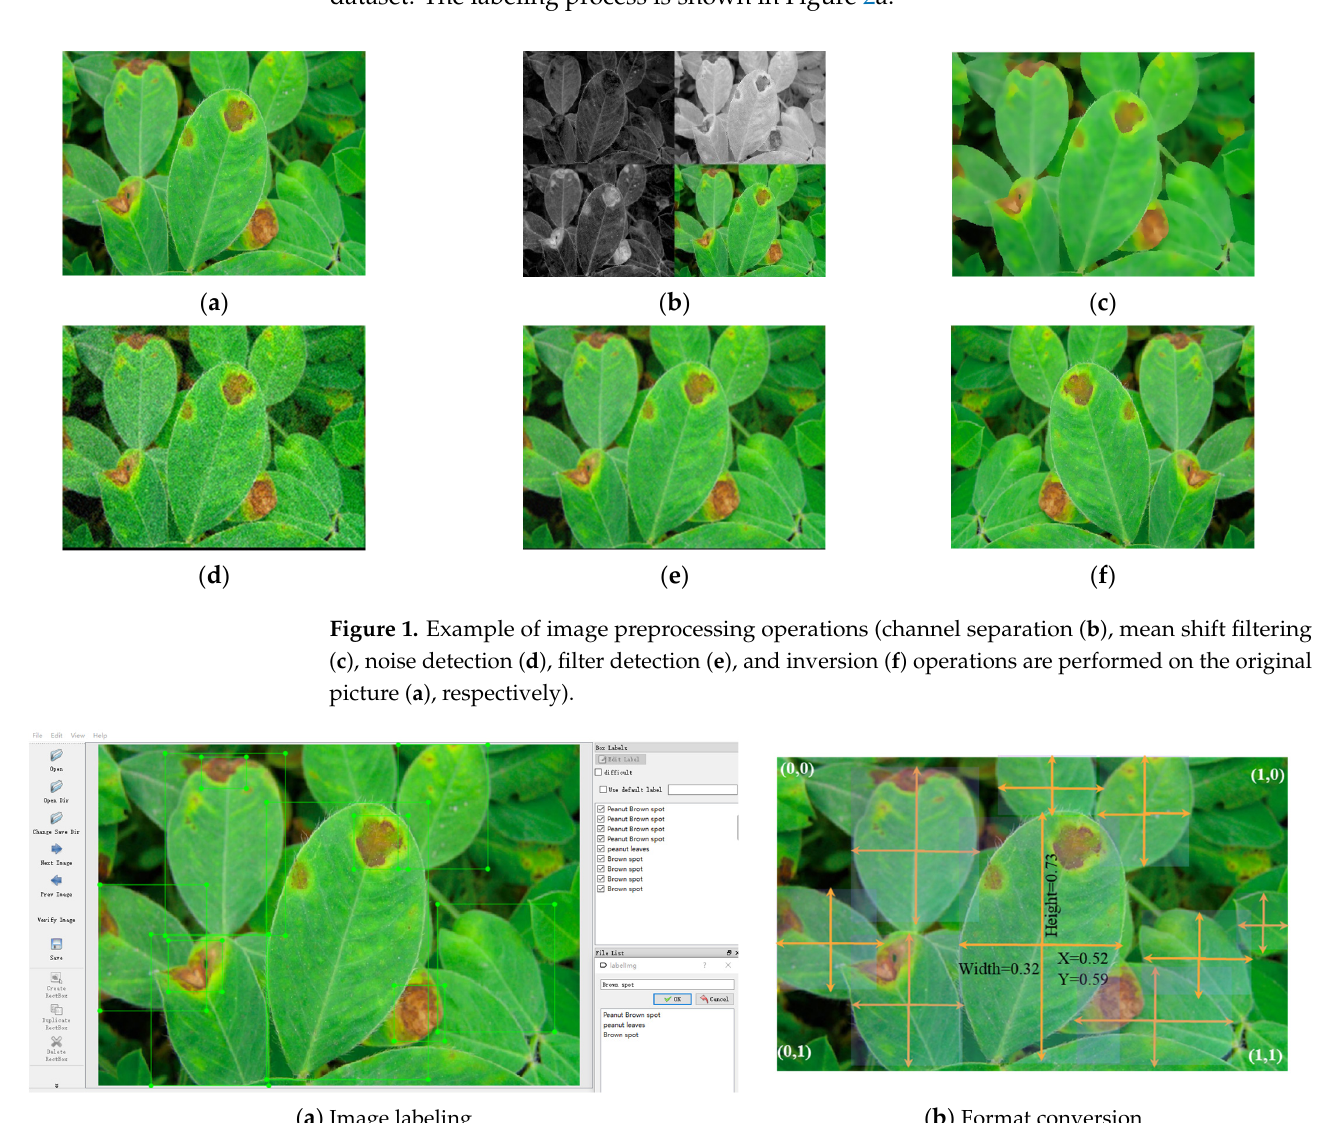
Figure 2. Example of image labeling ( a ) and format conversion ( b ).